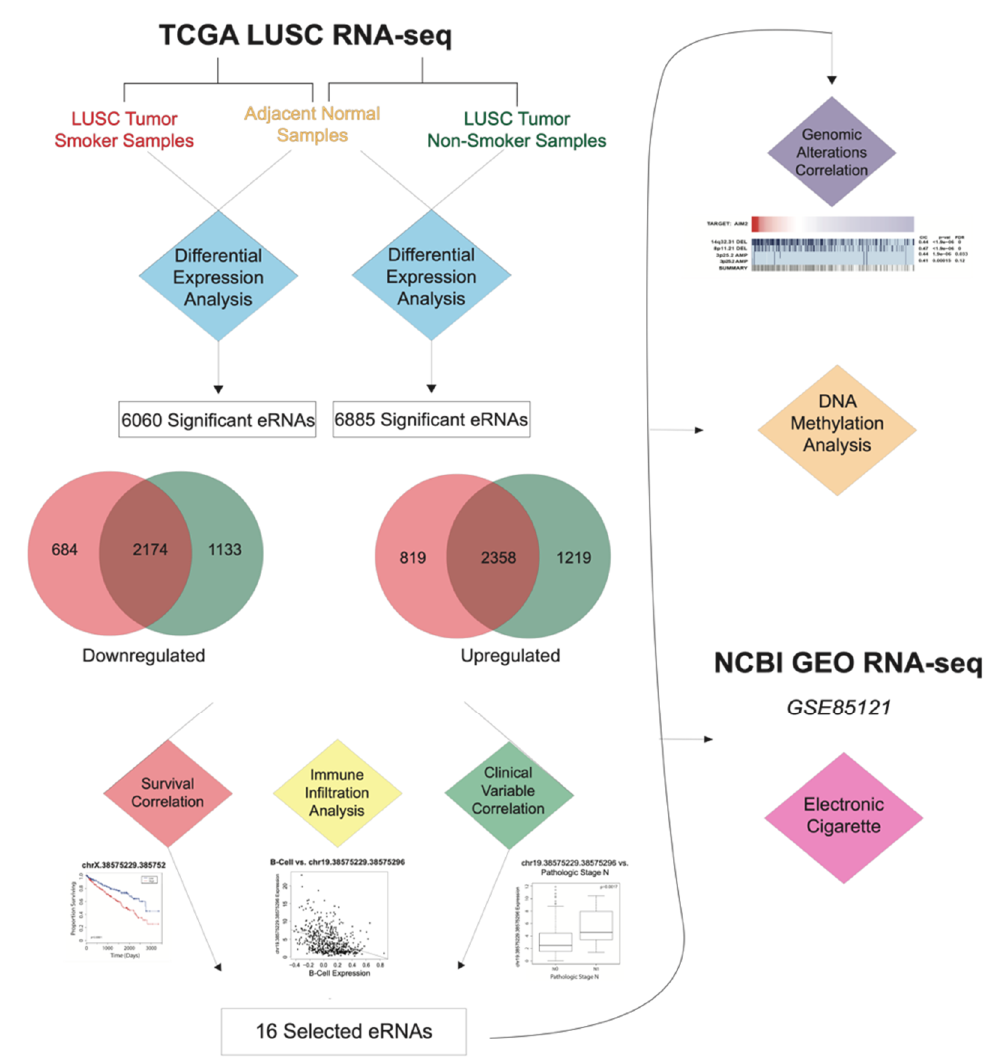
Figure 1. Project overview. Schematic of project workflow and analyses. Datasets were acquired from the Cancer Genome Atlas (TCGA) and the National Center for Biotechnology Information (NCBI) Gene Expression Omnibus (GEO). Tobacco- smoke-onset LUSC, nonsmoking-onset LUSC, and electronic cigarette smoke lung samples were analyzed in separate cohorts to limit any confounding variables. Differentially expressed eRNAs were filtered by log fold change and false discovery rate (log fold change (FC) > 1 and false discovery rate (FDR) < 0.05), and significantly dysregulated eRNAs were identified and used in survival analysis, immune infiltration analysis, and clinical variable correlations. A total of 16 key eRNAs were determined to be critical to the immune landscape and tumor phenotype of LUSC, based on previous analyses. These critical eRNAs were subsequently examined further for genomic alteration and methylation patterns.